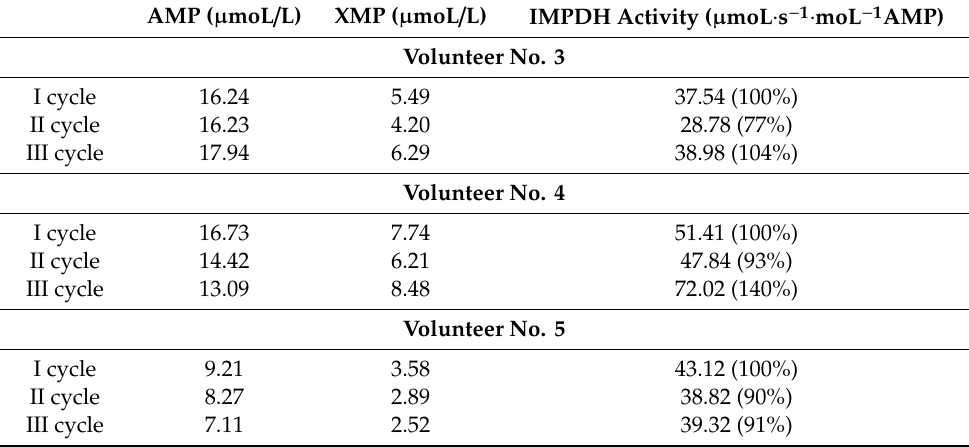
Table 1. The freezing–thawing stability of AMP, XMP, and inosine 5’-monophosphate dehydrogenase (IMPDH) activity determined in healthy volunteers.